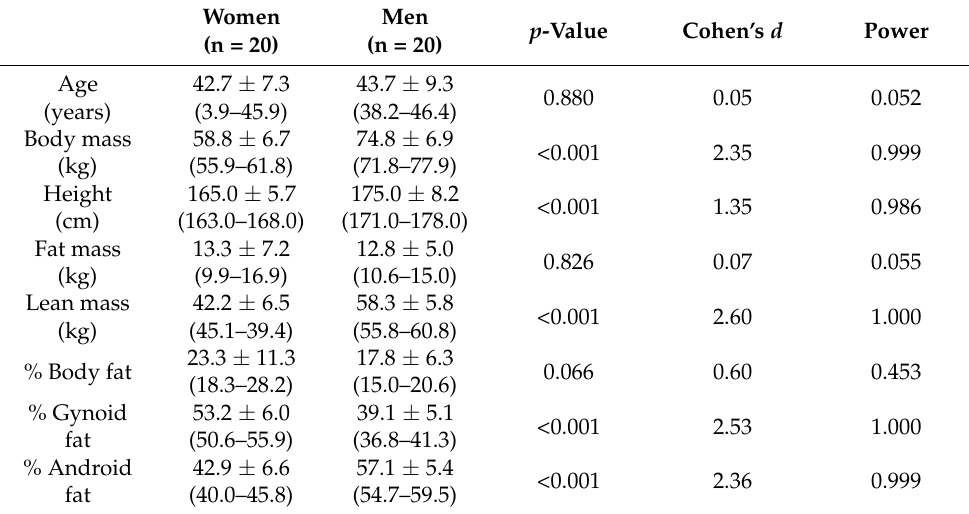
Table 1. Anthropometric data for men and